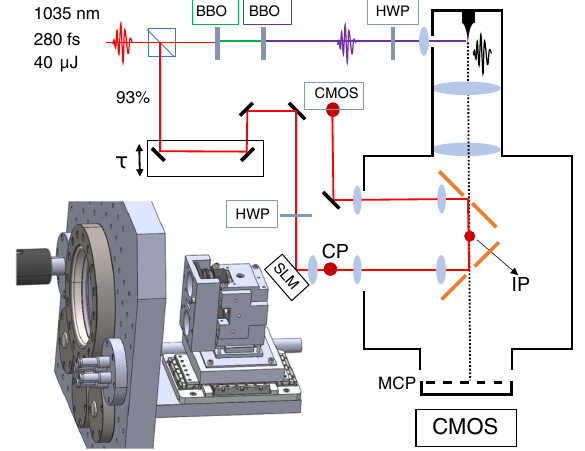
FIG. 1. Experimental setup: programmable ponderomotive deflection of electrons in free space. Outside of the vacuum chamber, the SLM-shaped laser distribution is formed in the conjugate plane ( CP ). In the specimen chamber, the electron beam interacts with a counterpropagating laser pulse in the interaction plane (IP). The induced electron phase modulations are proportional to the local laser pulse energy. Left: the modified SEM chamber door which allows for in- and outcoupling the shaped light fields (see also Appendix